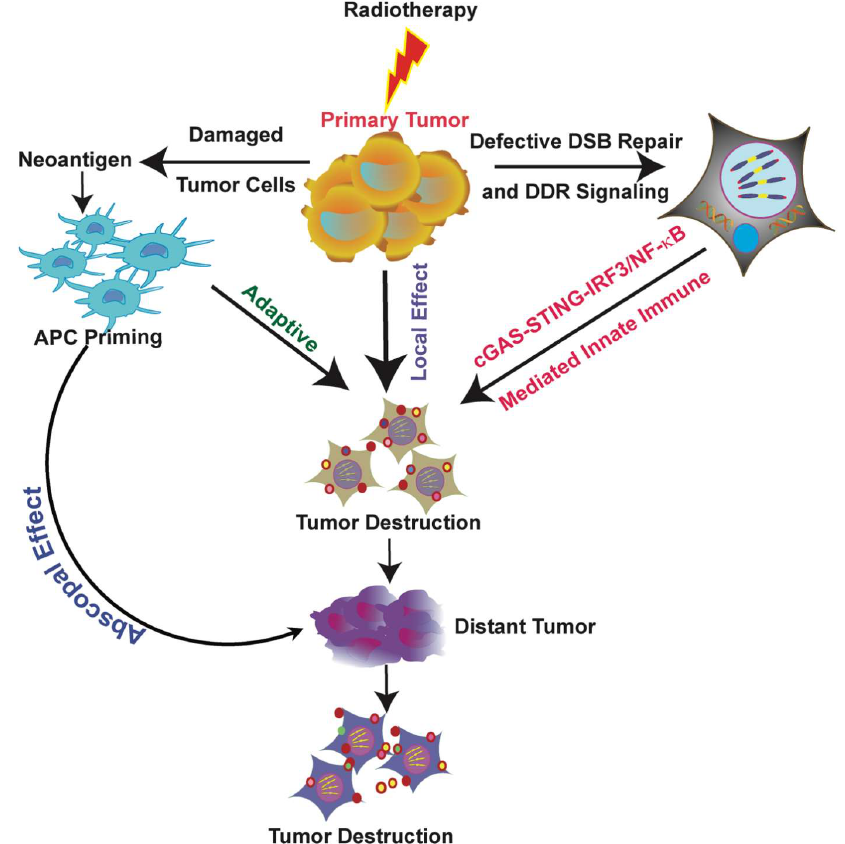
Figure 2. Schematic diagram of the comprehensive immunological effects of radiotherapy. DNA fragments generated by radiotherapy (RT) can trigger both adaptive and innate immune signaling pathways. RT causes double-strand DNA damage and destroys tumor cells. Tumor cell death exposes tumor antigens (neoantigens), which are specifically expressed on the tumor cell surface and activate antigen presenting cells (APC) like dendritic cells (DC). Primed DCs initiate adaptive immune response and kill tumor cells recognized by T cells, which play an important role in antitumor immunity. In addition, DNA damage releases fragmented DNA into the cytosol or generates micronuclei, which activates a cGAS-mediated innate immune response that destroys the tumor. RT primarily treats local tumors, but it can also inhibit distant tumors after local radiation, which is known as an abscopal effect. Thus, the systemic antitumor response to local treatment can target both local tumor cells and distant metastatic tumors.